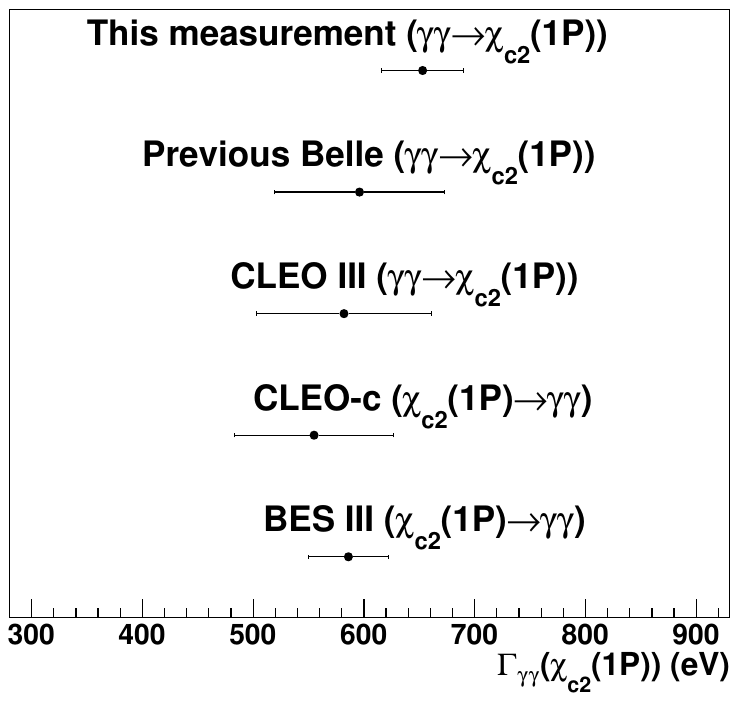
Figure 6 . Comparison of experimental results for Γ γγ ( χ c 2 (1 P )) , where the error bars show the combined uncertainties from all sources added in quadrature. This measurement supersedes the previous Belle result